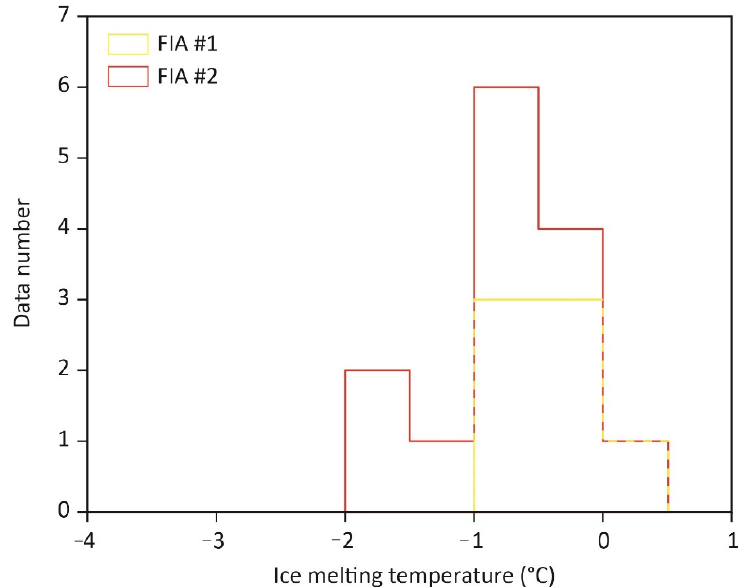
Figure 9. Frequency plot of ice melting temperature in 2 Fluid Inclusion Assemblage (FIAs) in quartz of type 1 veinlets.